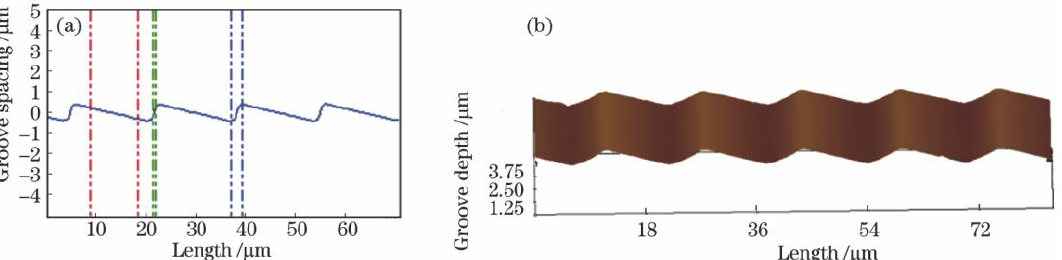
Figure 10. Convex grating cross-sectional profile. ( a ) Surface profile of convex grating [65]. ( b ) AFM morphology of convex grating [65].